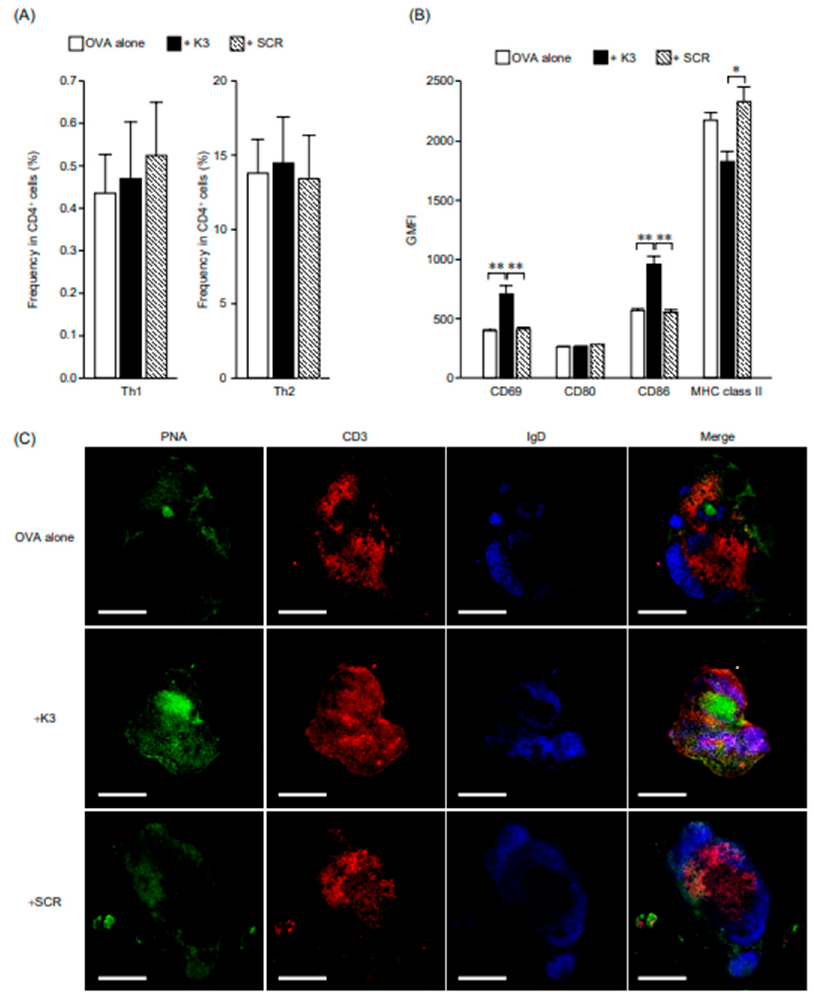
Figure 3. Effect of K3 on T and B cells in draining lymph nodes (dLNs) during primary immune response. C57BL/6 mice were immunized using the ovalbumin self-dissolving microneedle patch (OVA-sdMN) and K3-loaded hydrophilic gel patch (HG) methods with OVA, OVA + K3, or OVA + scramble (SCR) and analyzed as follows: ( A ) Two weeks later, the frequency of Th1 (Ki-67 + T-bet + ) or Th2 (Ki-67 + GATA3 + ) cells in CD4 + cells in dLNs was analyzed via flow cytometry. Data are expressed as mean ± SE of results from six mice. ( B ) After 3 d of immunization, expressions of CD69, CD80, CD86, and MHC II on B cells (B220 + ) in dLNs were analyzed using flow cytometry and shown as GMFI. Data are expressed as mean ± SE of results from three mice (Tukey’s test, * p < 0.05, ** p < 0.01). ( C ) Two weeks after immunization, dLNs were collected and germinal centers (GCs) were stained for IgD (blue), CD3 (red), and peanut agglutinin (PNA) (green). Representative photomicrographs are shown, and the white bar indicates a scale of 500 µ